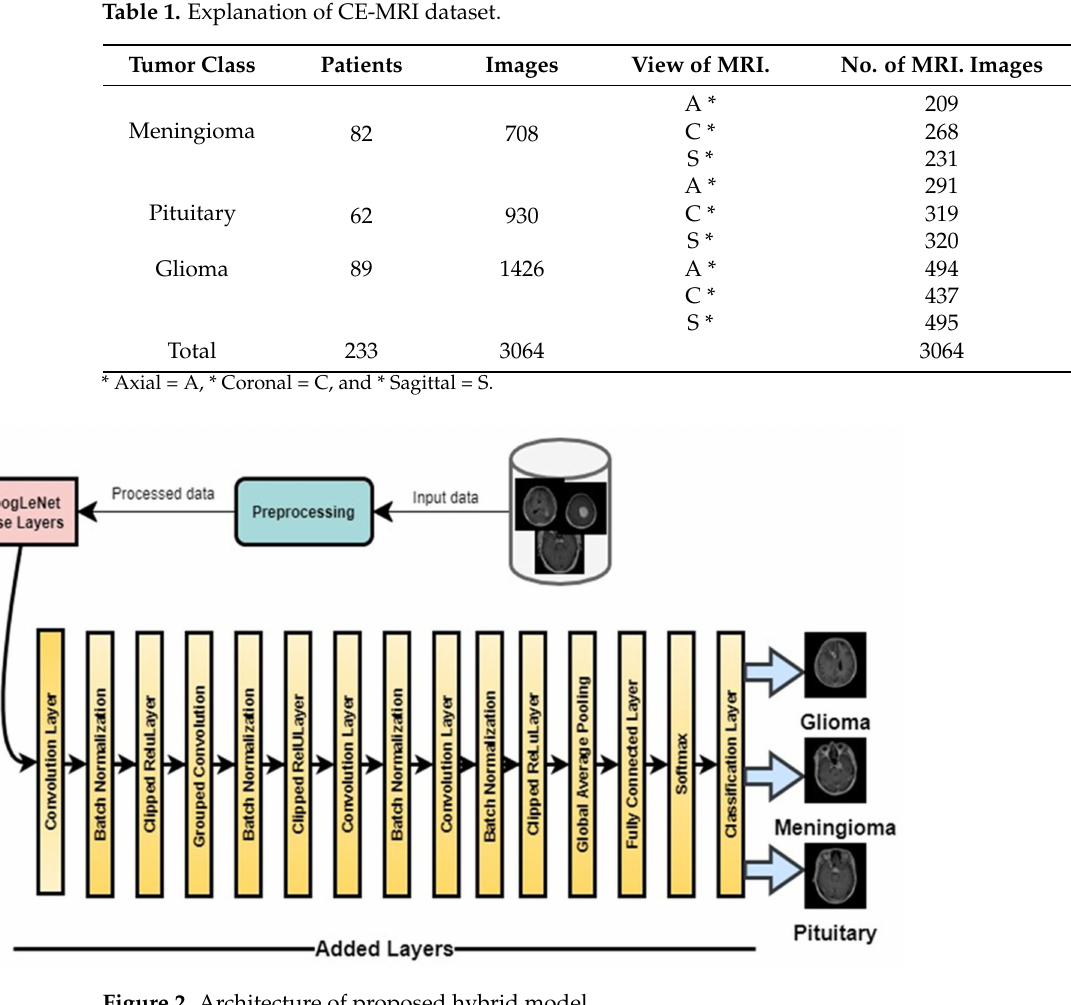
Figure 2. Architecture of proposed hybrid